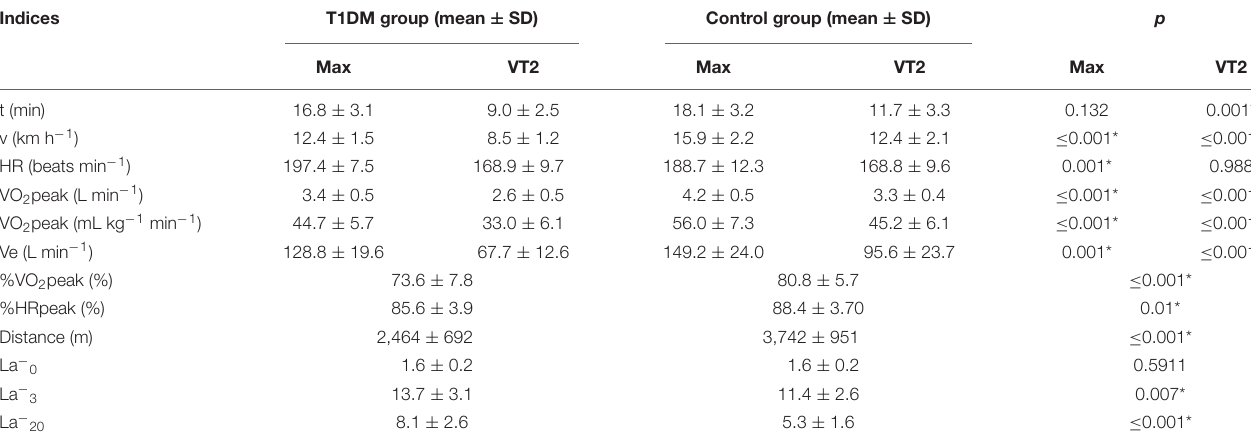
TABLE 4 | Physiological and biochemical indices. Indices